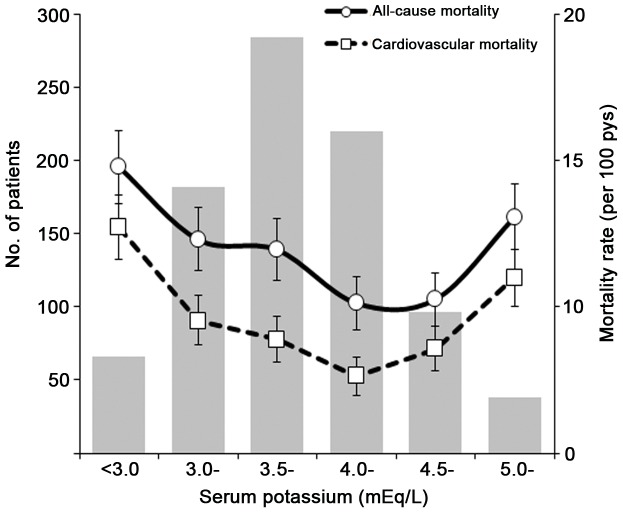
Distribution of baseline serum potassium levels and corresponding mortality rates.Gender- and age- standardized all-cause and cardiovascular mortality rates (per 100 patient-years) with 95% confidence intervals according to serum potassium categories at baseline.